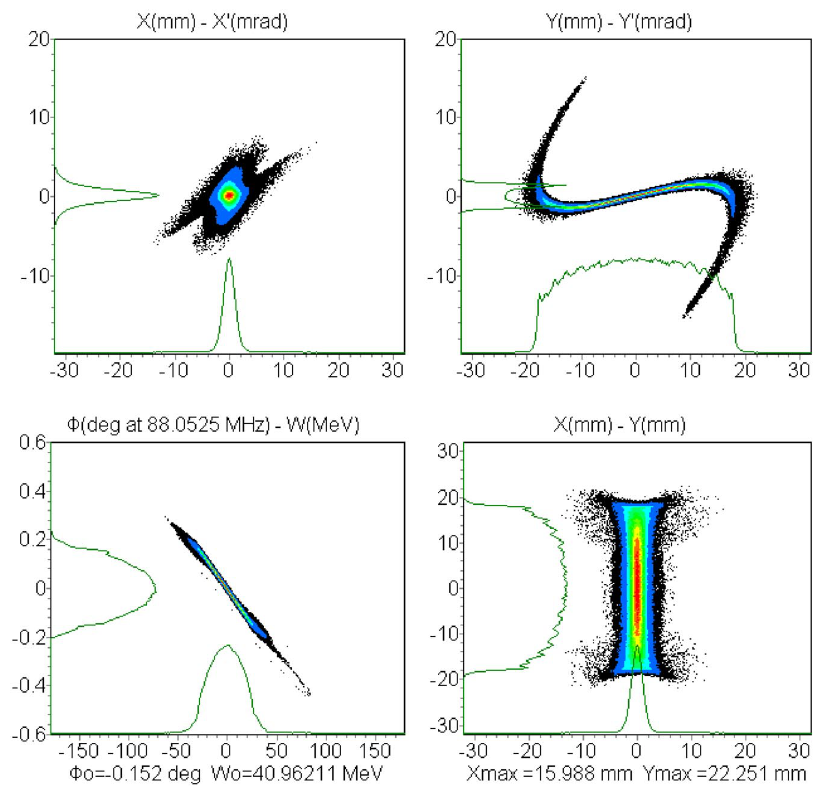
FIG. 3. (Color) The density portrait of the deuteron beam at the linac exit in the phase space.